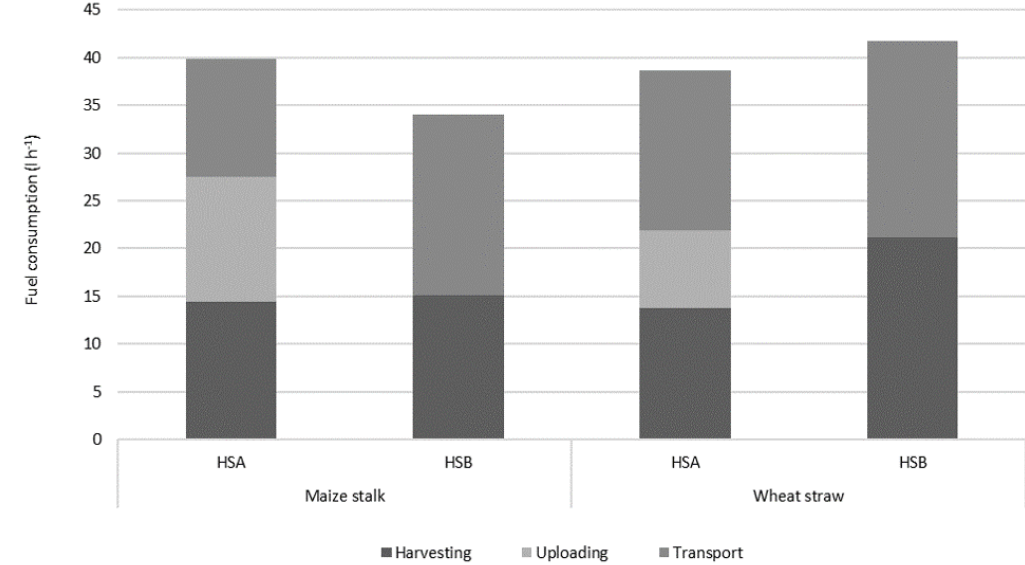
Figure 3. Fuel consumption of the harvesting system “A” (HS-A) and harvesting system “B” (HS-B) for wheat straw and maize stalks.